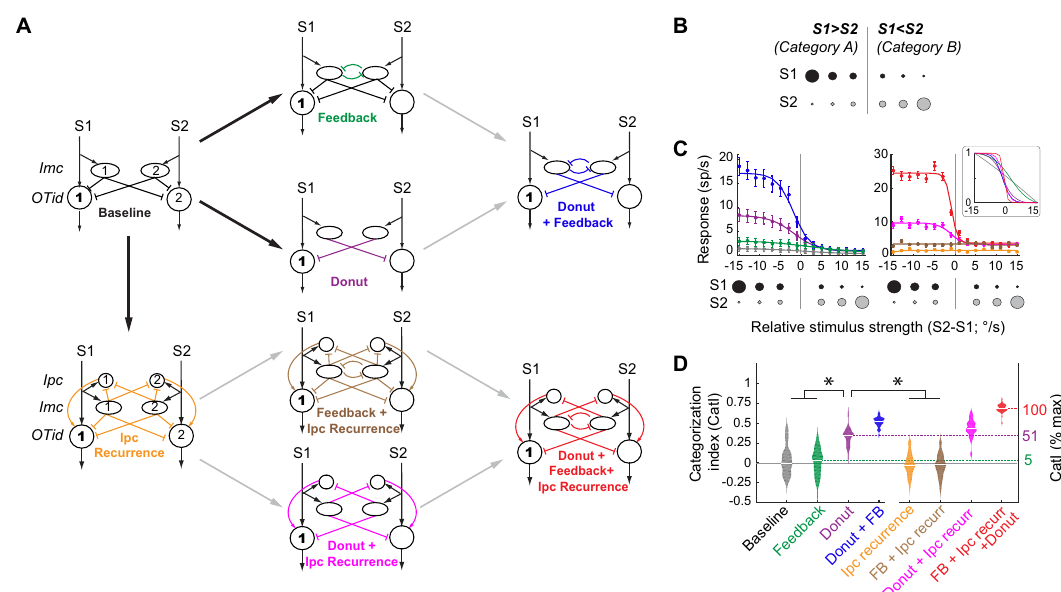
Fig. 2 Donut-like inhibition surpasses other hypothesized circuit motifs for generating categorical responses in models of the avian midbrain selection network. A Computational models incorporating combinations of three different circuit motifs proposed in the literature as underlying categorical responses (Methods; Fig. S1). All models built upon generic “ baseline ” circuit (left column-top) capable of comparing competing options. Each model shows two “ channels ” ; each channel is the group of neurons (numbered) involved in representing a stimulus (S1 or S2). Large circles: OTid neurons; ovals: Imc neurons; small circles: Ipc neurons. Arrows with pointed heads - excitatory connections, arrows with fl at heads - inhibitory connections. The three circuit motifs are – feedback inhibition between competing channels (green; middle column - top), donut-like inhibition (self-sparing inhibition; purple; middle column-second from top; see also text), and recurrent ampli fi cation within each channel (through “ Ipc ” neuron; orange; left column-bottom). The goal of output neuron 1 (bold face) in each model is to signal if S1 > S2 (category “ a ” ) or S2 > S1 (category “ b ” ), when presented with S1 and S2 of varying relative strength following strength-morphing protocol. B Strength-morphing protocol (Methods). S1 and S2 are presented simultaneously “ to ” the model, S1(2) is inside the receptive fi eld of neurons in channel 1 (2). As strength of S1 is decreased, that of S2 is systematically increased; strength of the stimuli is controlled by their loom speeds (°/s); denoted here by size of dots. Gray line: ideal selection boundary (when relative strength = 0). C Simulated response pro fi les of output neuron 1 from each of the models (colors) in A obtained using the strength- morphing protocol (bottom inset). Responses are mean ± s.e.m of 30 repetitions. The continuously varied input parameter was the relative strength of the two stimuli (S2-S1). Lines – best sigmoidal fi ts. Input-output functions of model neurons were sigmoids with Gaussian noise (Methods; fano factor = 6). Right-Inset: Response pro fi les normalized between 0 and 1; only means are shown for clarity. D “ Population ” summary of CatI of response pro fi les from various circuit models (colors); n = 50 model neurons; center lines in the violin plots indicate median values. * p < 0.05, One-way ANOVA followed by Holm-Bonferroni correction for multiple paired comparisons; only a key subset of signi fi cant differences indicated for clarity. green vs. gray: p = 0.99, purple vs. gray: p = 5.98e-8, blue vs. purple: p = 5.98e-8, red vs. purple. See also Fig. S1. Source data are provided as a Source Data fi